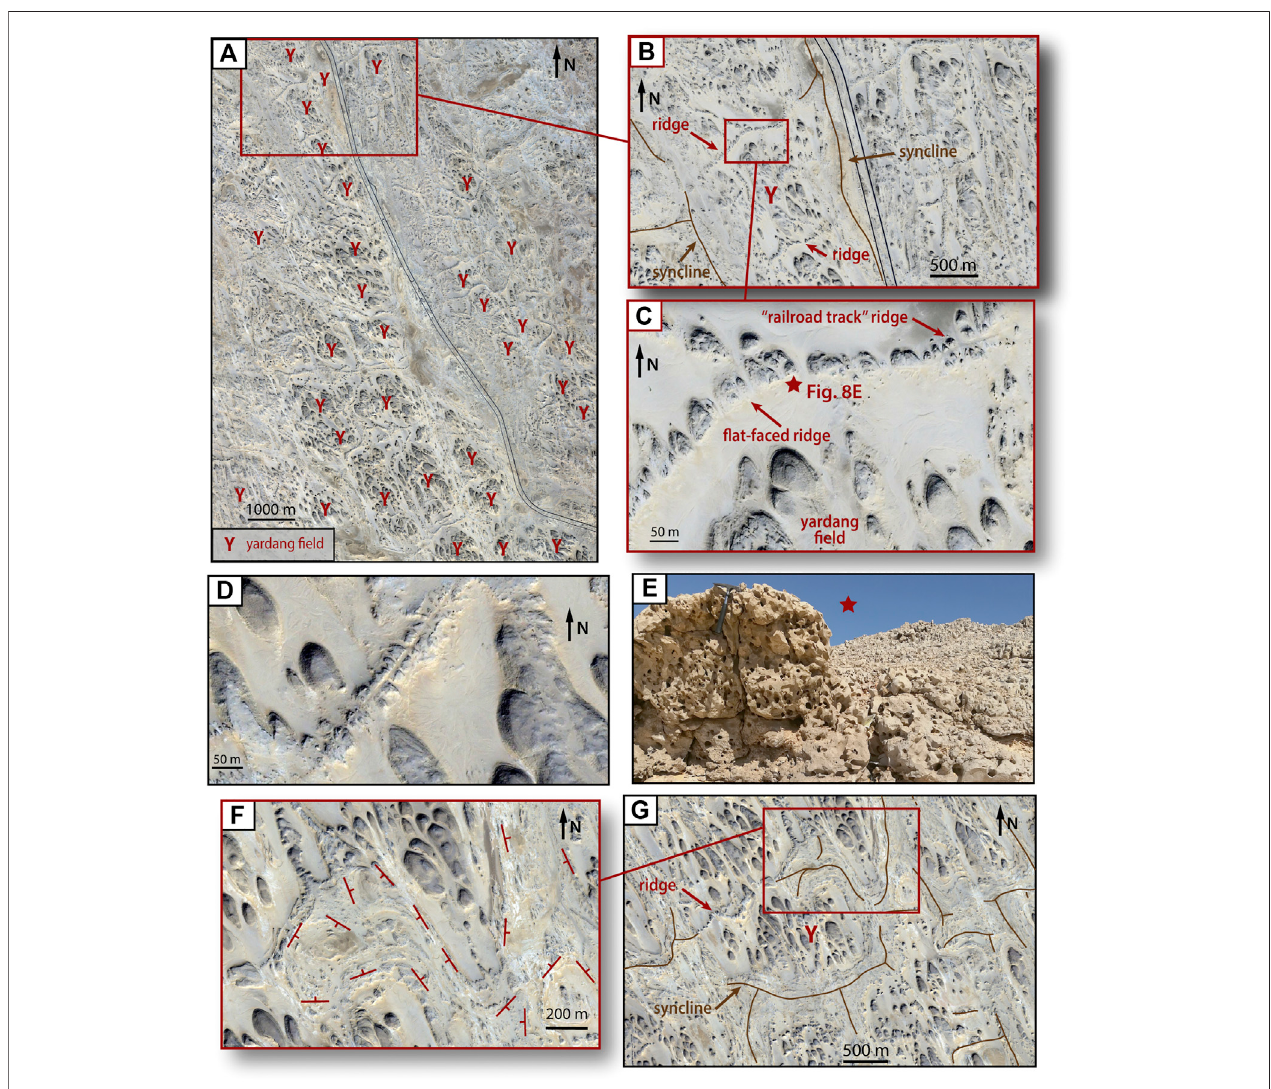
FIGURE 8 | (A) Ghost network terrain with quasi-polygonal yardang fi elds ( Y ) 700 – 2,000 m across. Figure 7 shows location. (B) Yardang fi eld ( Y ) separated from adjacentyardang fi eldsonNWandSEsidesbynarrowridges. (C) Ridgeshavequasi-horizontalbeddingandcommonlyhaveone fl at,erodedverticalface. (D) “ Railroad track ” ridge with a less resistant core. (E) Honeycomb structure in ridge face at star in (C) . (F) Typical ghost network syncline almost entirely in white limestone units. (G) Yardang fi eld ( Y ) separated from adjacent yardang fi elds by synclines on all but NW side. Figure 7 shows location. Satellite imagery source: Google Earth. Coordinates for Google Earth images: A) 26.741701, 31.196545; B) 26.780786, 31.178656; C) 26.783211, 31.172064; D) 26.419267, 31.267455; F) 26.577290, 31.261319; G) 26.569470, 31.260204. Field location: E) 26.783773,